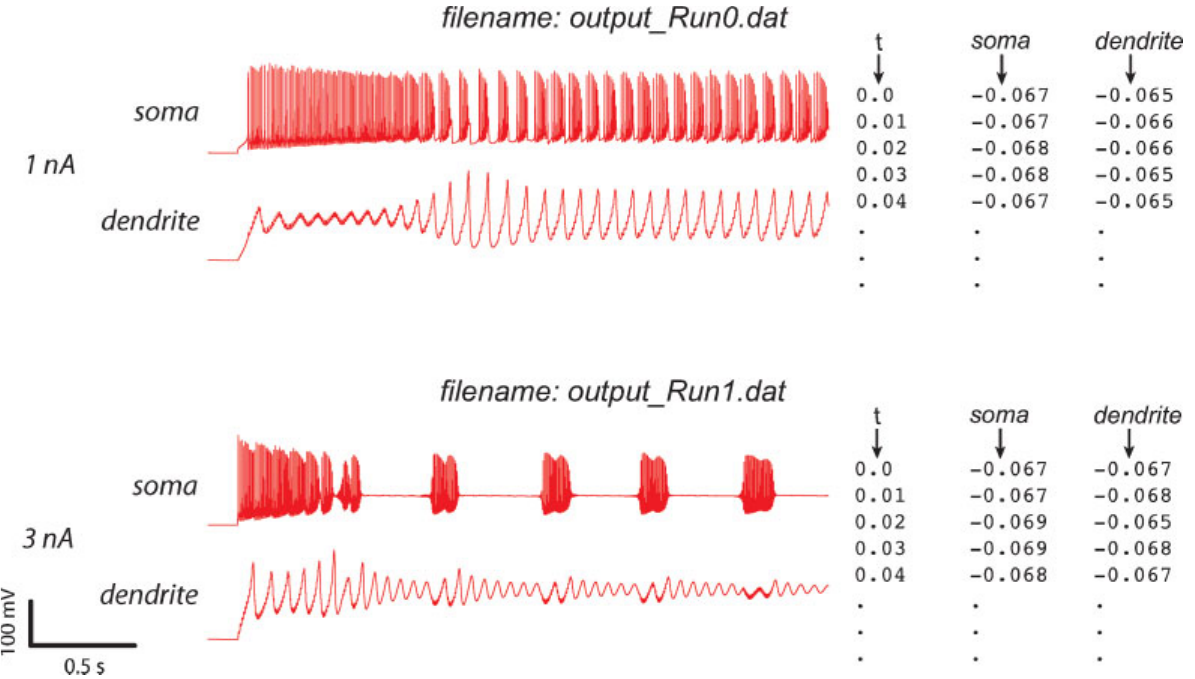
Figure 3. Experimental data format . The format of the ASCII experimental files is shown ( right ) with the corresponding data traces ( left ). If the experiment consists of a recording at two sites, with two different consecutive injections (current amplitudes 1 and 3nA), two files should be created output Run0.dat and output Run1.dat, each containing one column with the timestamps and two columns with the recorded data (V) in soma and dendrite. Example was made using the PC model (De Schutter and Bower, 1994).